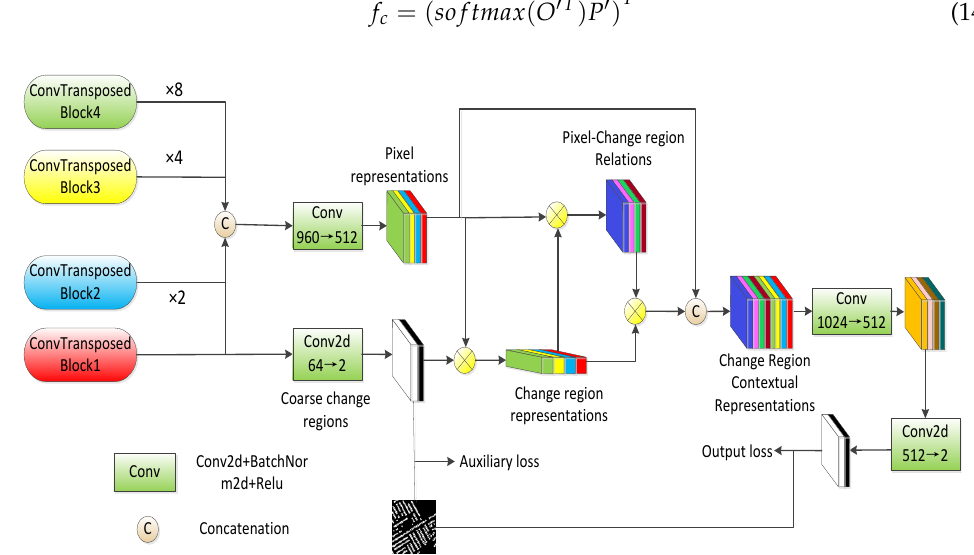
Figure 6. Structure of the change contextual representational module.